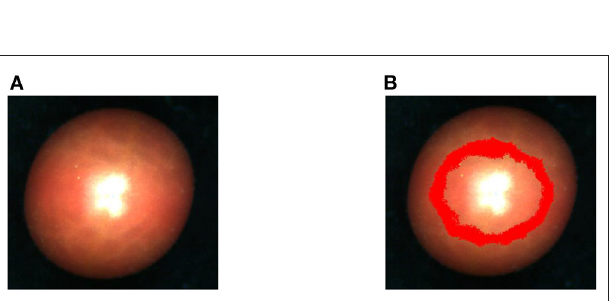
of view of 7 ◦ . The objective lens had a 17 mm focal length (maximum aperture of F1.4), optimized for the